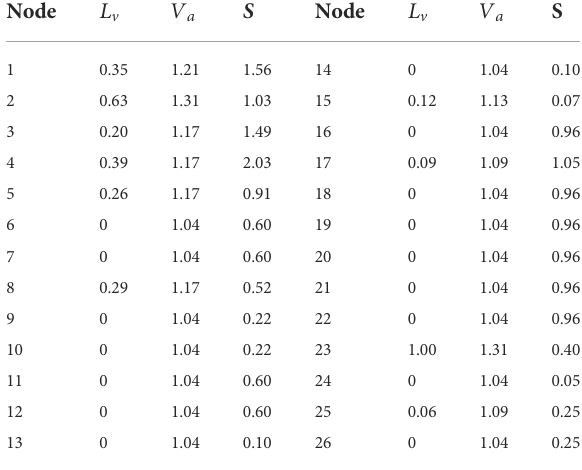
TABLE 1 The importance of the nodes calculated by DIL L v , initial voting ability V a , and the voting score of nodes S after the fi rst round of voting in example